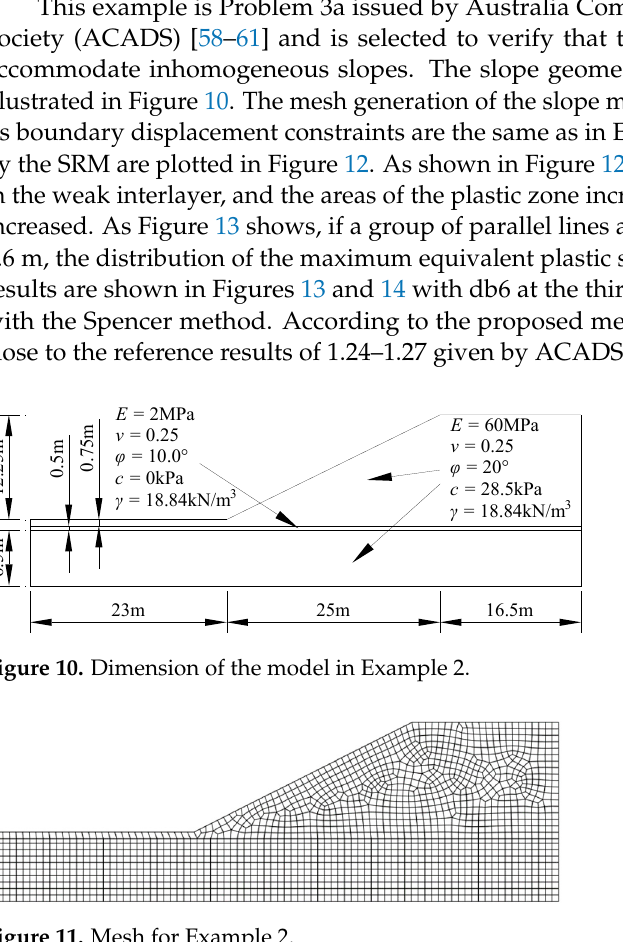
( a ) ( b ) Figure 12. The contours of equivalent plastic strain by the SRM for Example 2. ( a ) F i = 1.15; ( b ) F i = 1.31. Figure 13. The contour of equivalent plastic strain, distribution of the maximum equivalent plastic strains, and the CSS for Example 2. Figure 14. Critical slip surfaces based on wavelet packet and Spencer for Example 2. The proposed FOS=1.31 The Spencer FOS=1.30